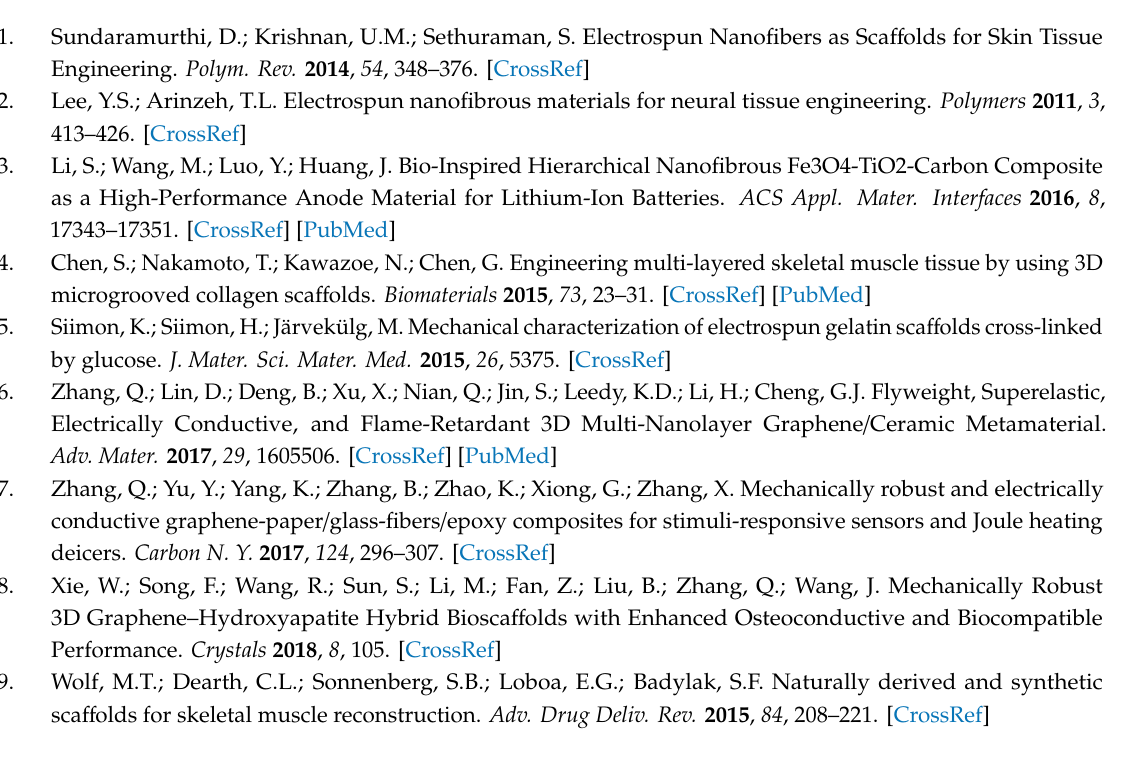
Figure S1: Square wave potential steps at 0.65 V to − 0.6 V in CCM solution of CFS and CFS-PPyTF samples at 0.01 Hz: Figure S2: Square wave potential steps of CFS and CFS-PPyTF at applied frequencies 0.0025 Hz to 0.1 Hz, Table S1: Strain ε and stress di ff erences ∆ σ of CFS and CFS-PPyTF at applied frequencies 0.0025 Hz to 0.1